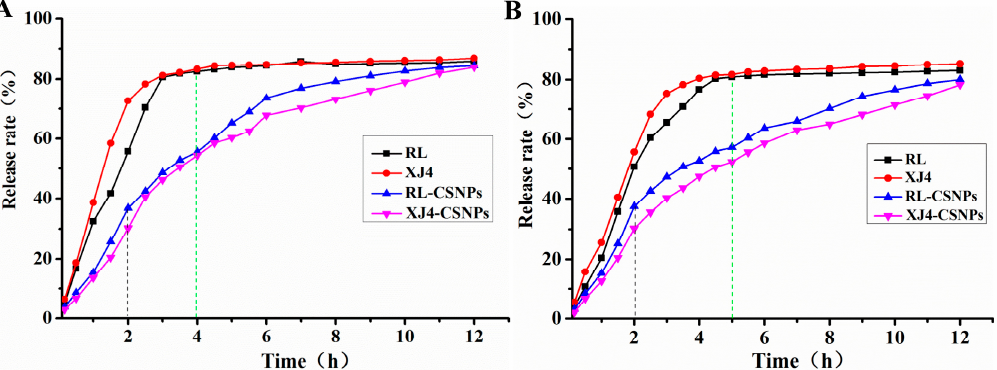
Figure 8. In vitro release rates of anthocyanins before and after nanocrystallization. ( A ) Simulated gastric (pH 2.0) condition; ( B ) simulated intestinal (pH 7.0) condition.